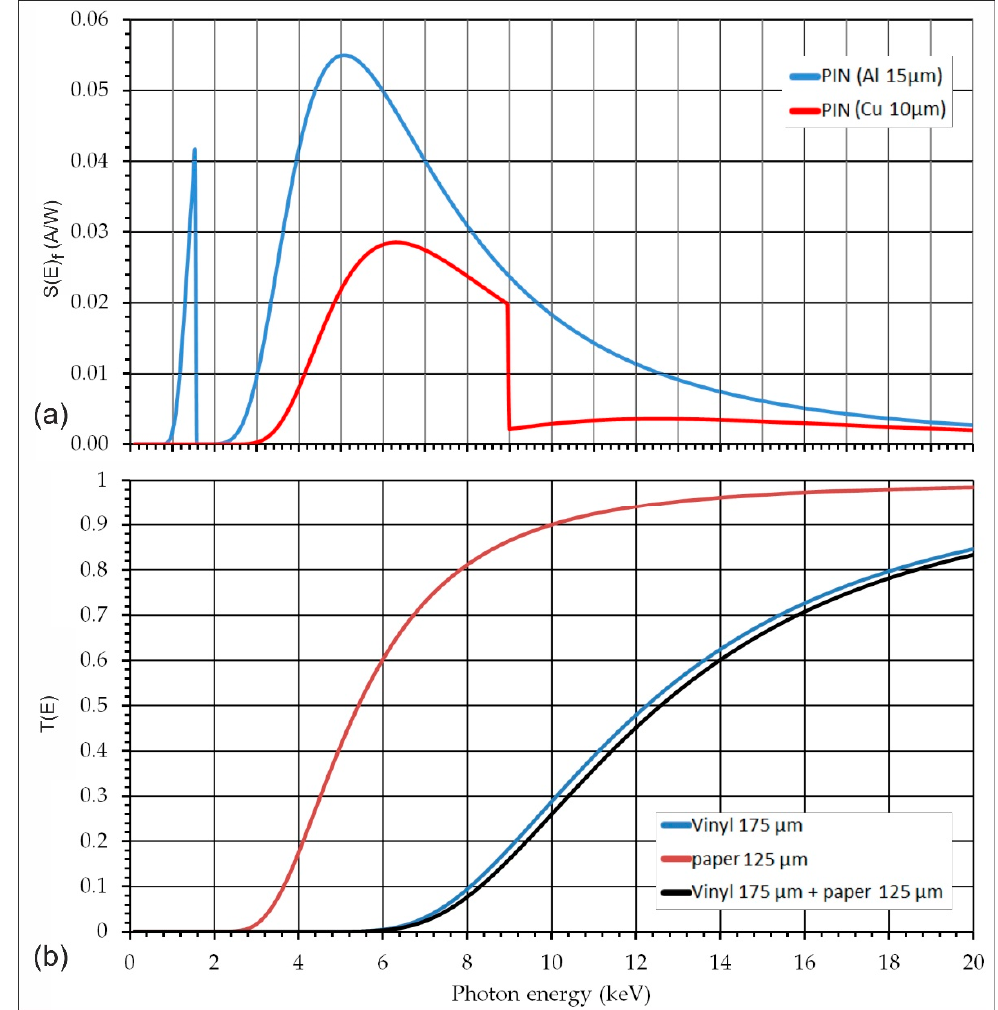
Figure 2. ( a ) Filtered BPX65 PIN photodiode’s spectral sensitivity as a function of the photon energy, for the Al (15 μ m) and Cu (10 μ m) filters. ( b ) X-ray spectral transmission profile of the film package: paper foil (125 μ m), vinyl case (175 μ m), and the overall transmission of the package.